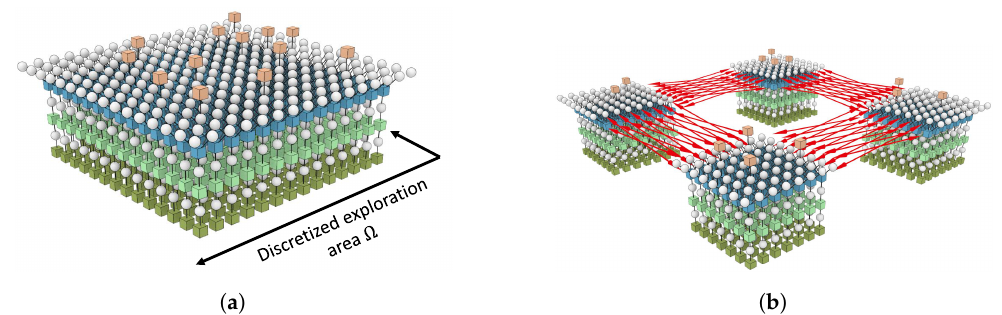
Figure 3. ( a ) FG model of a discretized PDE describing a gas diffusion process at a fixed time instance over grid cells in the spatial domain Ω . At each grid cell, there is a layer of nodes that describes the probabilistic relationship of the gas diffusion process in this specific cell. The skin-colored nodes at the top represent measurements of gas concentration at a specific location. ( b ) The FG model is partitioned into four smaller FGs on four agents to enable distributed inference. Red arrows indicate where information between the smaller FGs needs to be exchanged in order to realize inference.